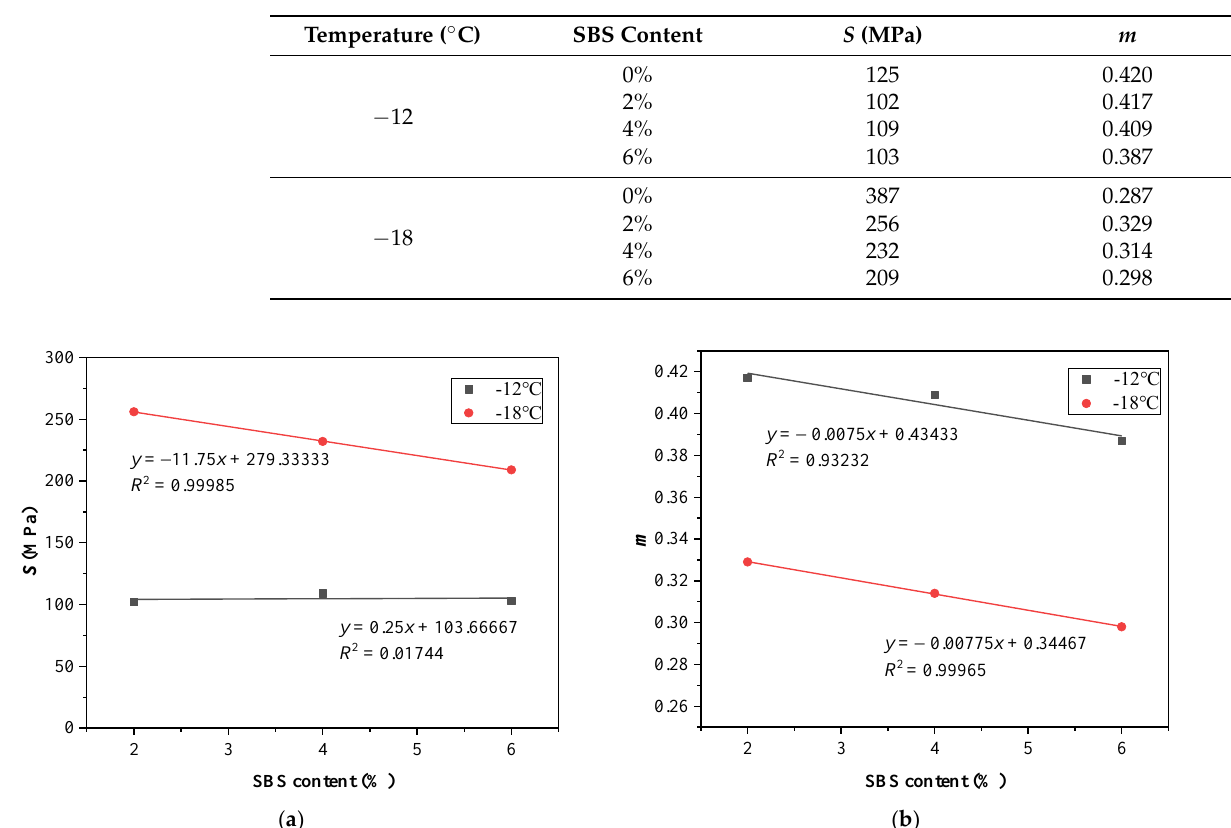
Table 3. BBR test results.